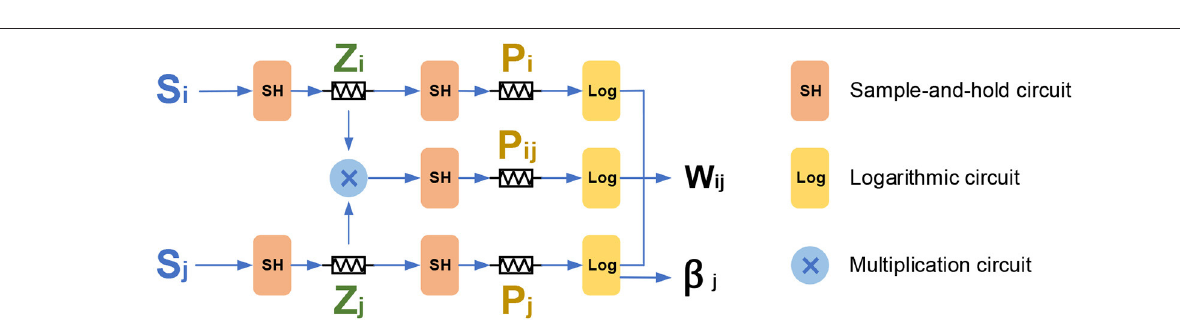
FIGURE 5 | The basic memristor-based architecture for the BCPNN learning rule.